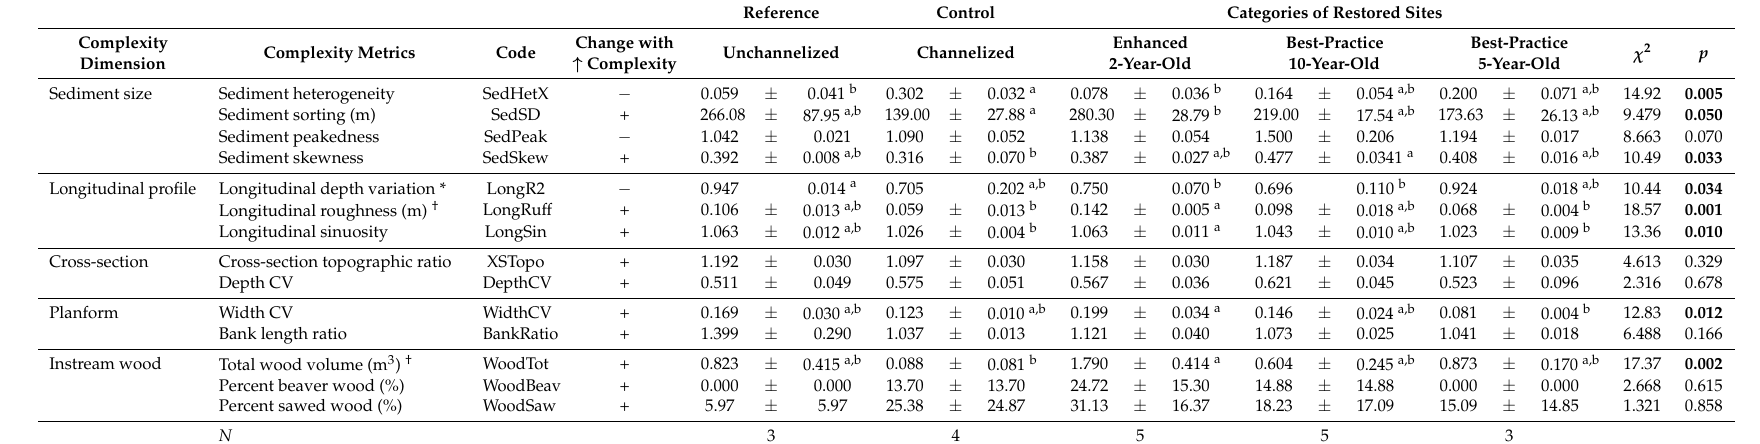
Table 2. Differences in geomorphic complexity among restoration statuses based on results of linear mixed-effect models (LMM). Differences among the restoration statuses were determined using pairwise comparisons among the least-square means, and equivalent test to Tukey’s honest significant difference test, but for LMMs. Means and standard errors are reported; letters denote significant pairwise differences, values that share a letter are not different from each